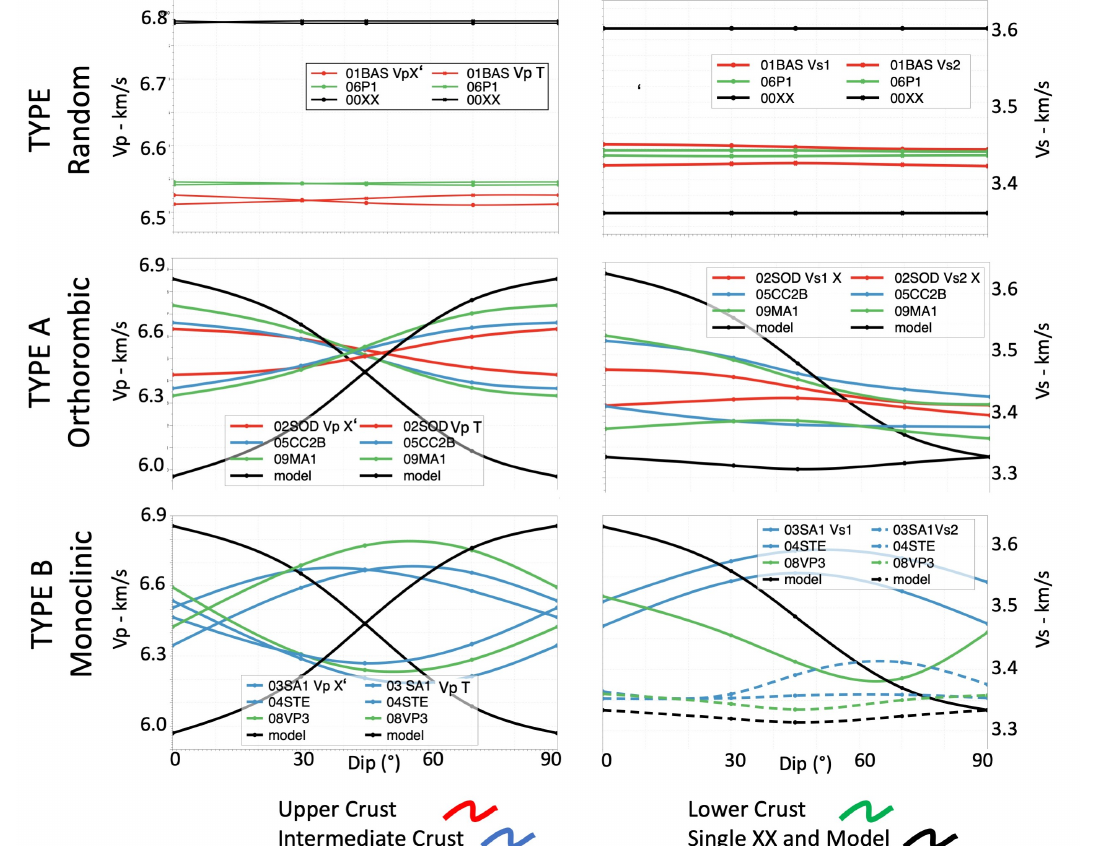
Figure 9. Vp components propagating horizontally (X’ component) and vertically (T component)—Vs1 and Vs2 horizontal components. See text for